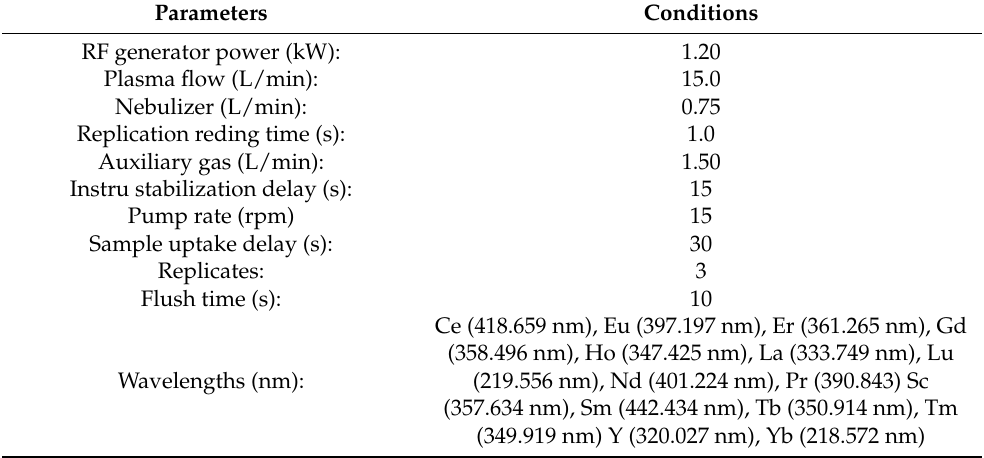
Table 1. ICP-OES operating